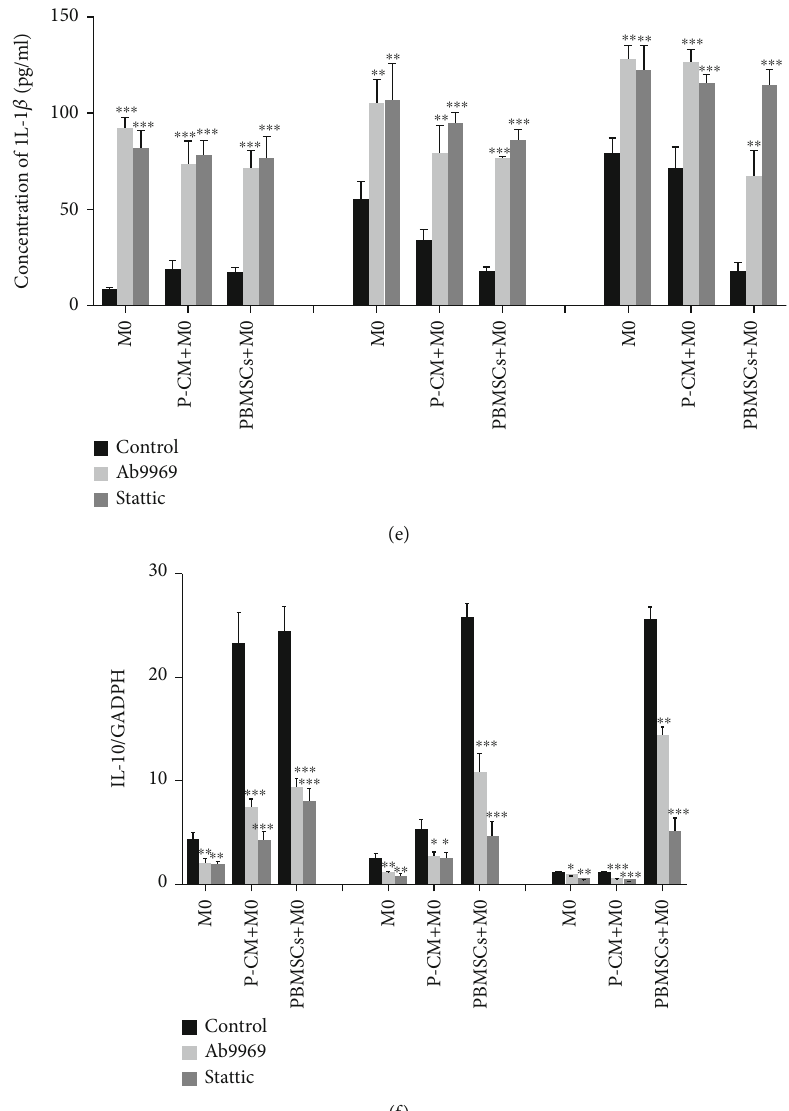
Figure 4: E ff ect of inhibiting the IL-10/STAT3 pathway on the secretion and expression of in fl ammatory cytokines in various groups. (a, c, e) Concentrations of IL-10 (a), TNF- α (c), and IL-1 β (e) in the supernatant from the M0, P-CM+M0, and PBMSC+M0 groups were detected by ELISA, after inhibiting the IL-10/STAT3 pathway for 6 h, 2d, or 4d. (b, d, f) mRNA expression levels of IL-10 (b), TNF- α (d), and IL-1 β (f) in macrophages from the M0, P-CM+M0, and PBMSC+M0 groups were measured by RT-qPCR after inhibiting the IL-10/STAT3 pathway for 6h, 2d, or 4d. Graphs show the mean ± standard deviation ; n = 3 ; ∗ P < 0 : 05, ∗∗ P < 0 : 01, and ∗∗∗ P < 0 : 001 , compared with the M0 group. ELISA: enzyme-linked immunosorbent assay; GAPDH: glyceraldehyde 3-phosphate dehydrogenase; IL: interleukin; P-CM: PBMSC-conditioned media; PBMSCs: peripheral blood-derived mesenchymal stem cells; RT-qPCR: real-time quantitative polymerase chain reaction; TNF: tumor necrosis